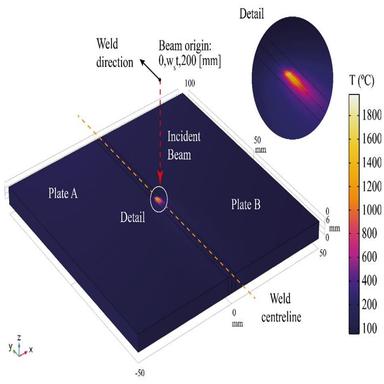
Finite element thermal analysis (FETA) of the Eurofer 97 laser-keyhole 6 mm plate butt-weld.